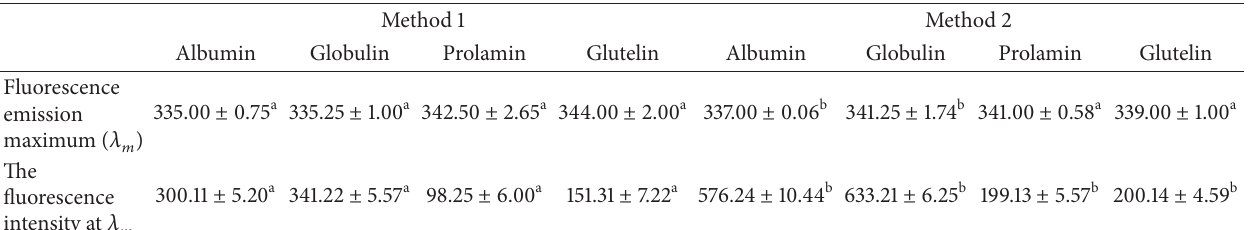
Table 3: Parameters of the intrinsic emission fluorescence spectra of FRBPs prepared by the two extraction methods.